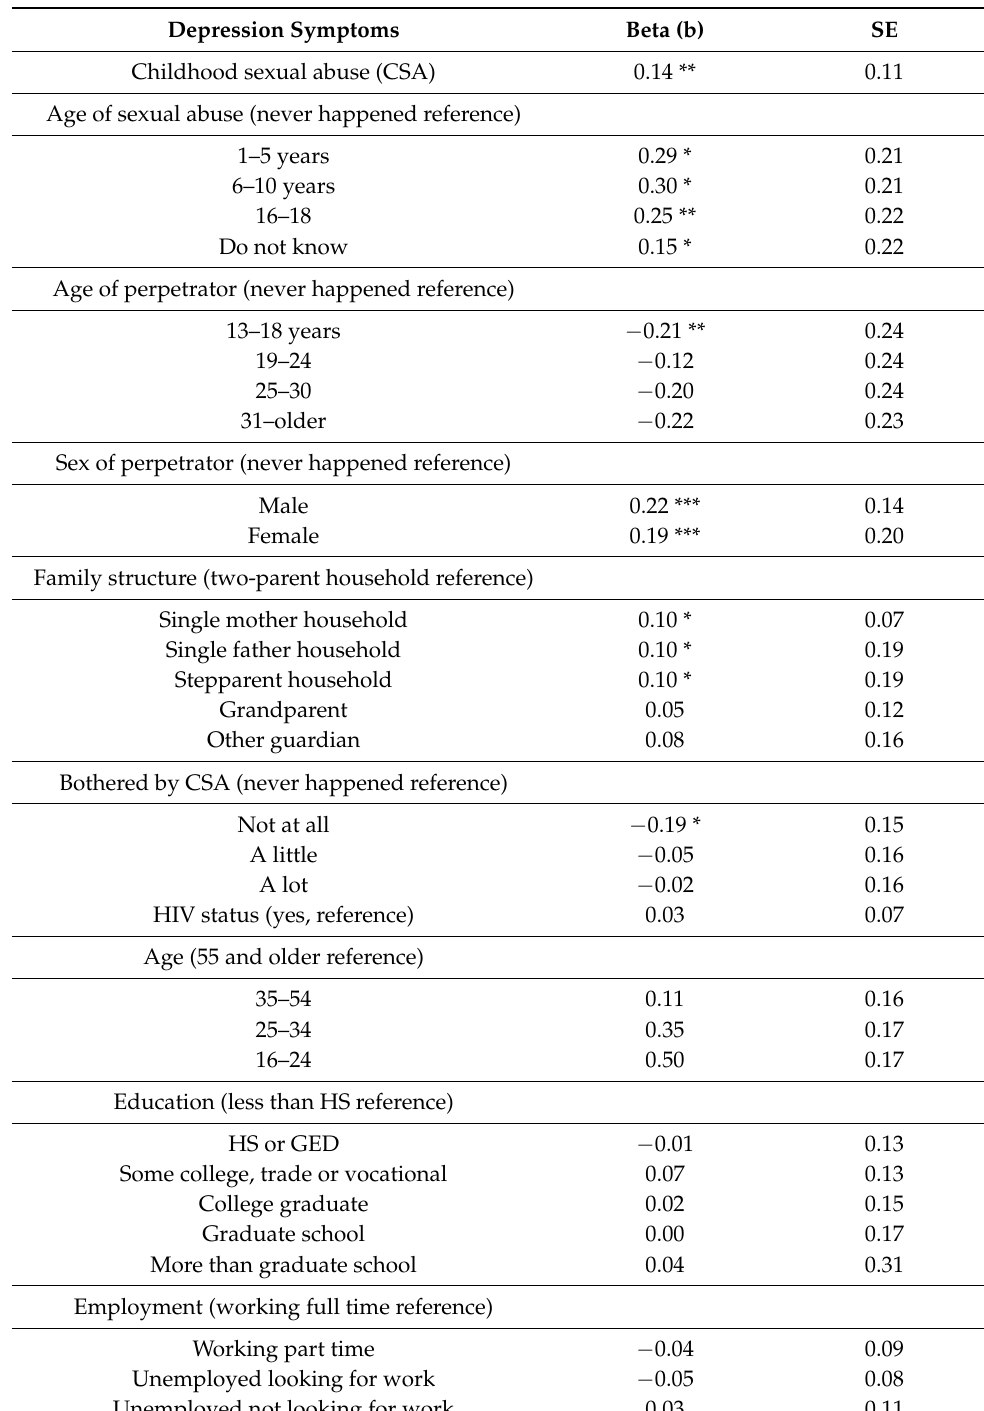
Table 4. Multiple regression with study variables on depression symptoms (N =